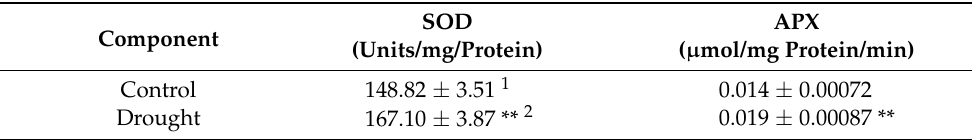
Figure 1. Effects of drought stress on the value of oxygen radical antioxidant capacity (ORAC) in lettuce. Each seedling was treated by lowering the water level by 0 cm (control, white bars) or 4 cm (drought stress, gray bars) for 7 days. ORAC value in the hydrophilic fraction ( left ) and a hydrophobic fraction ( right ) was measured using Trolox equivalent to the standard. The vertical bar indicates a standard error of nine replicates of the total ORAC value. ** Significant differences between control and drought stress at p = 0.01 with Student’s t -test. Table 1. Effects of drought stress on the activities of enzymes for biosynthesis of antioxidants.